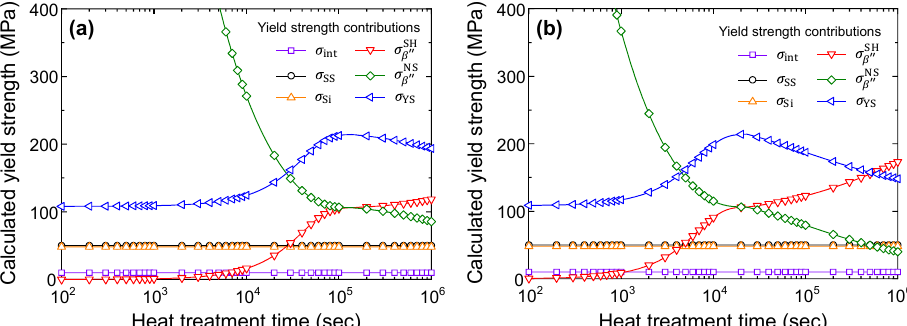
Figure 13. Calculated yield strength contribution of each phase at different temperature conditions: ( a ) 160 ◦ C and ( b ) 200 ◦